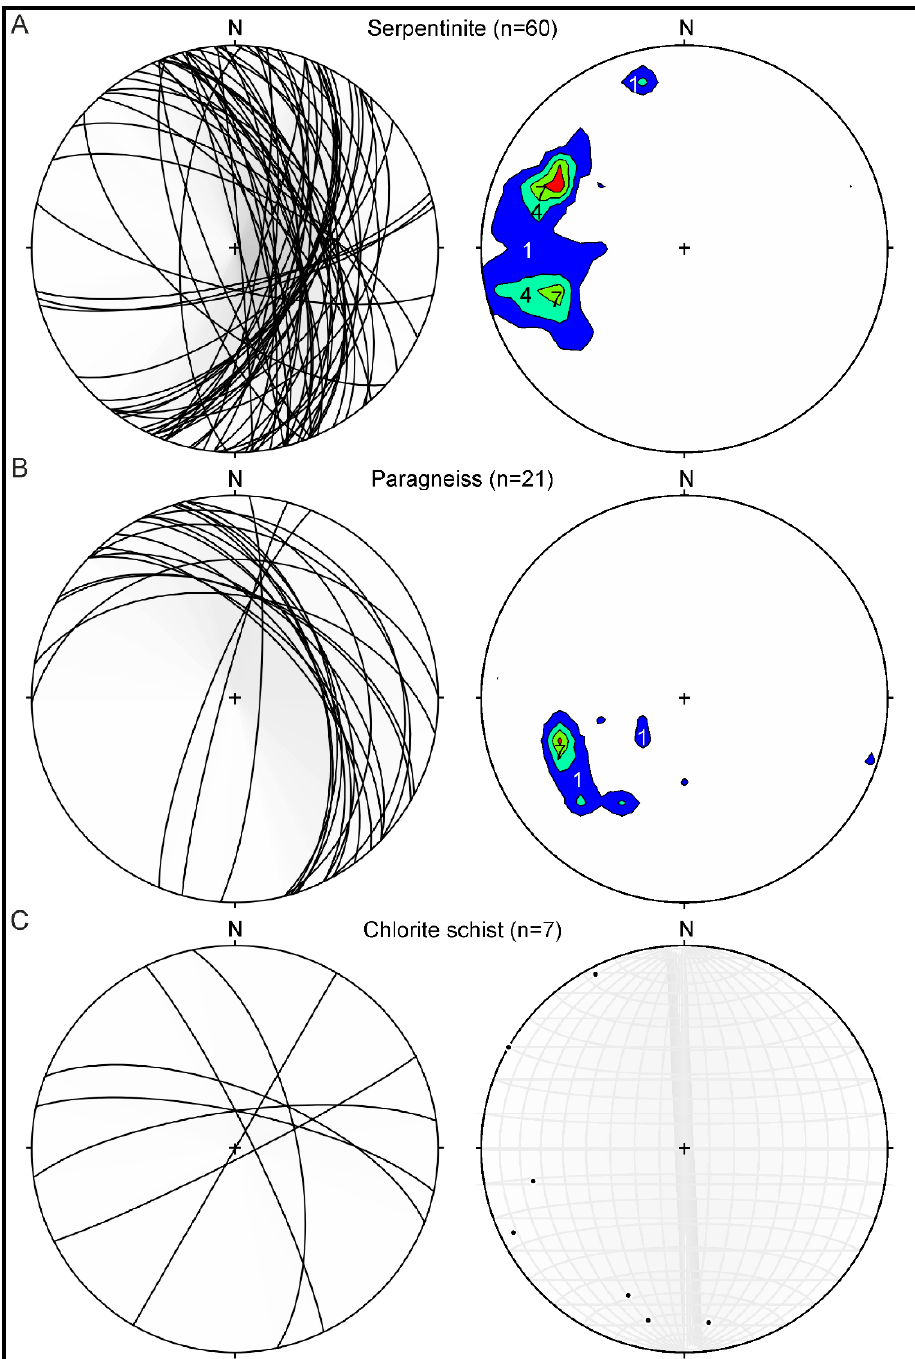
Figure 4. Schistosity orientation presented on a lower hemisphere projection (stereograms developed in Stereonet v. 10.2.8 software). Left panels—structures presented as planes, right panels—presented as poles to planes (C) or density plots for poles to planes (A, B; contours per 1% area: 1, 4 and 7%). ( A ) Serpentinite; ( B ) Adjacent paragneisses; ( C ) Serpentinite-hosted chlorite schists.